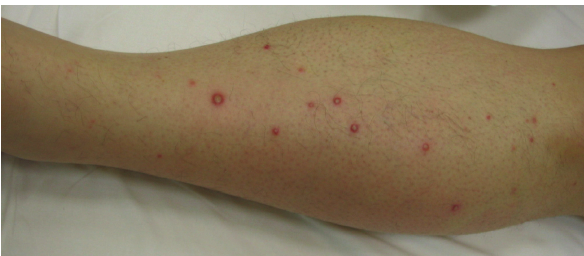
Figure 1: Skin vesiculobullous lesions on left leg.